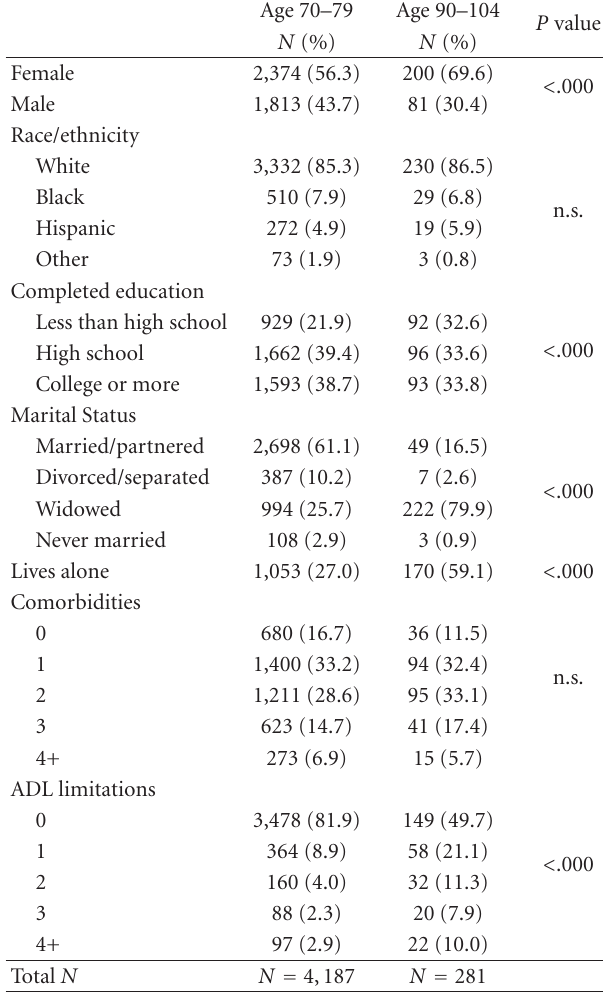
Table 1: Sample characteristics by age